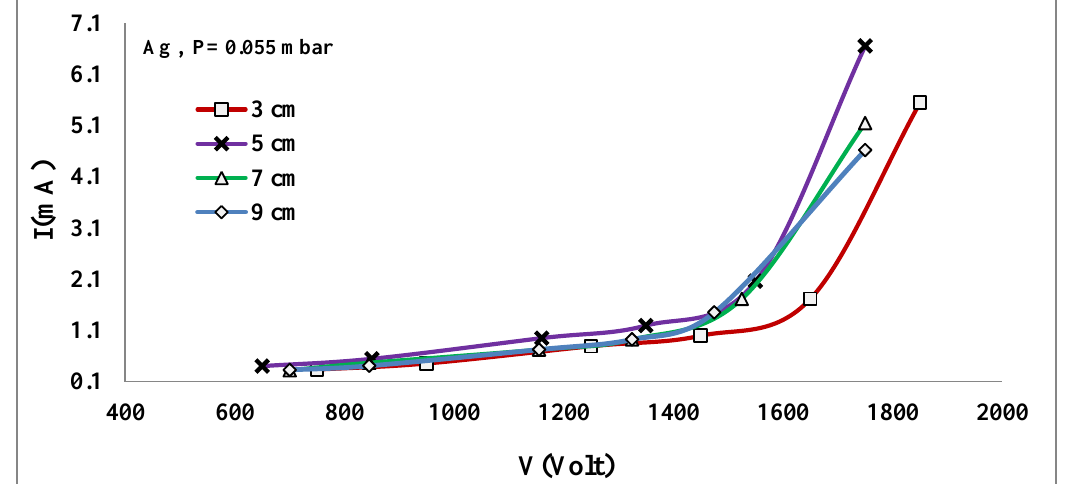
Fig. 3: The variation of discharge current with applied voltage at different distances of Ar gas for silver target.